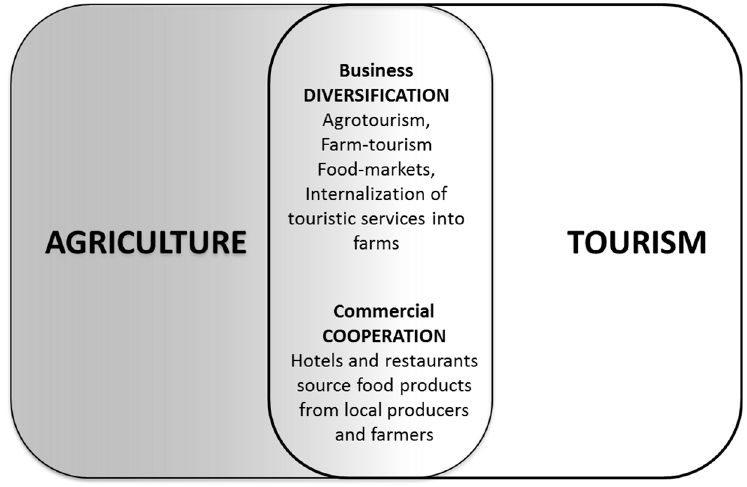
Figure 1. The two approaches to cooperation between agriculture and tourism. Source: own elaboration.